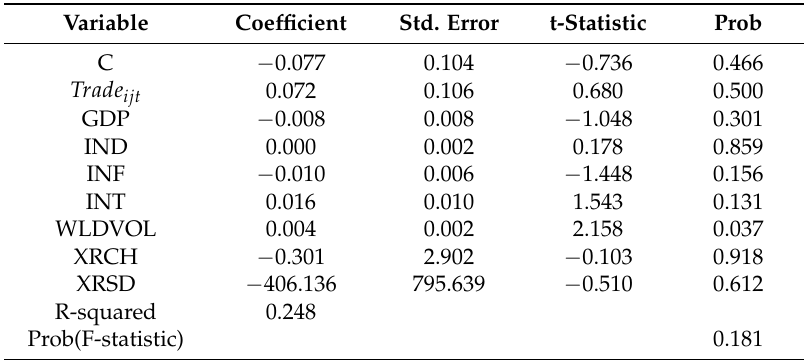
Table 7. Determinant of Stock Market Co-movement between Pakistan and Indonesia.